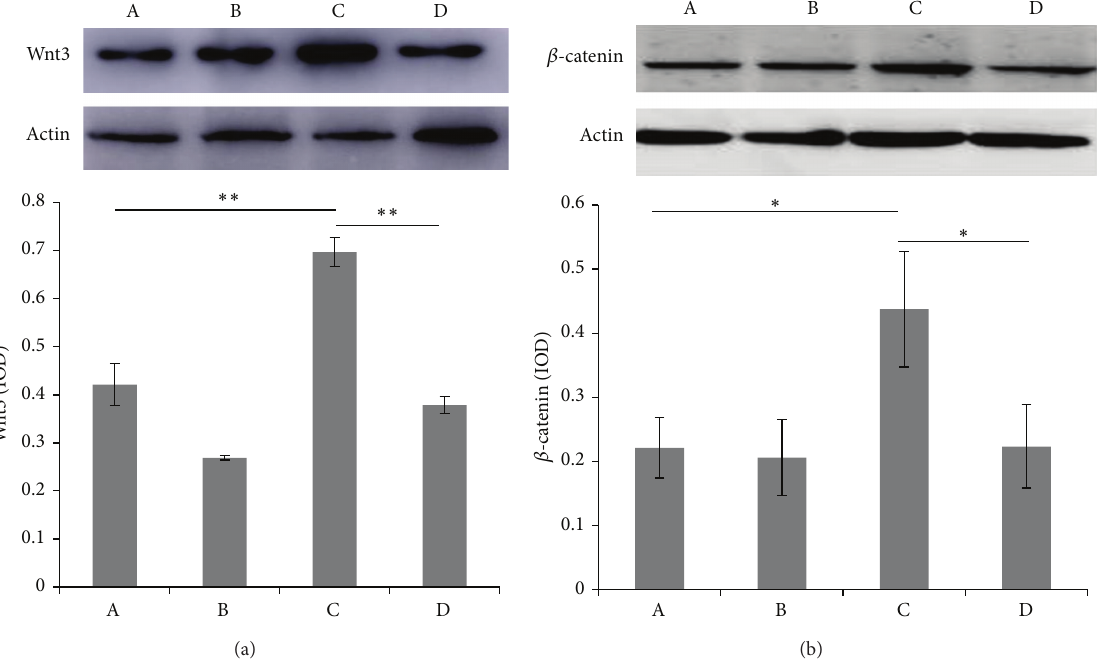
Figure 4: Western blot for the expression of Wnt3 and 𝛽 -catenin in guinea pig scleral fibroblasts. (a) Western blot for the expression of Wnt3. (b) Western blot for the expression of 𝛽 -catenin. (A) SC group, (B) SC + DKK-1, (C) FDM, and (D) FDM + DKK-1. ∗∗ 𝑃 < 0.01 , ∗ 𝑃 < 0.05 .